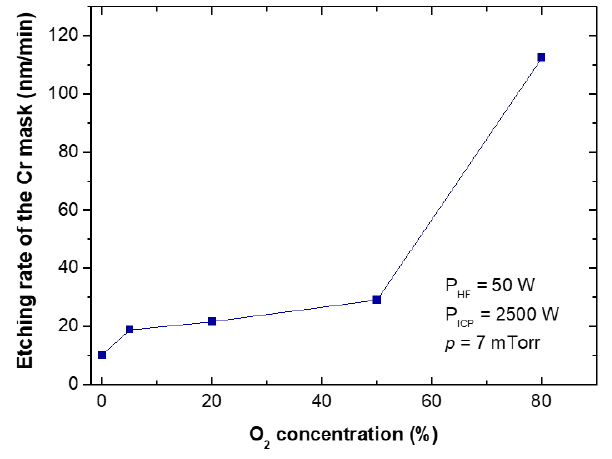
Figure 10. The relationship between oxygen concentration in the SF 6 plasma and the Cr mask etching rate. Fixed parameters are included in the inset.